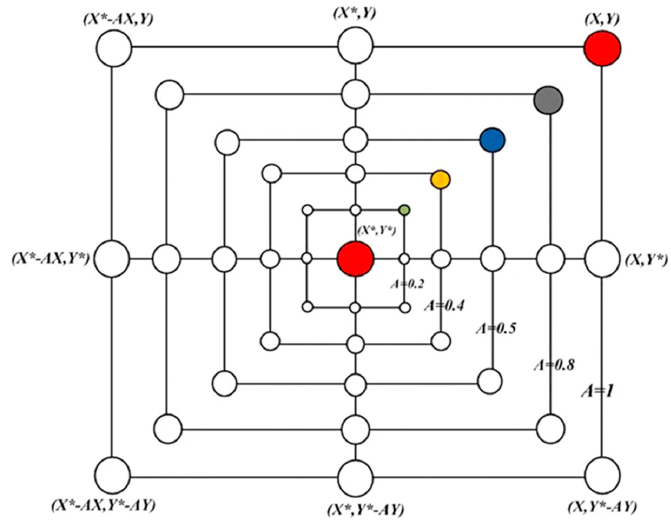
Figure 1. Shrinking encircling mechanism.